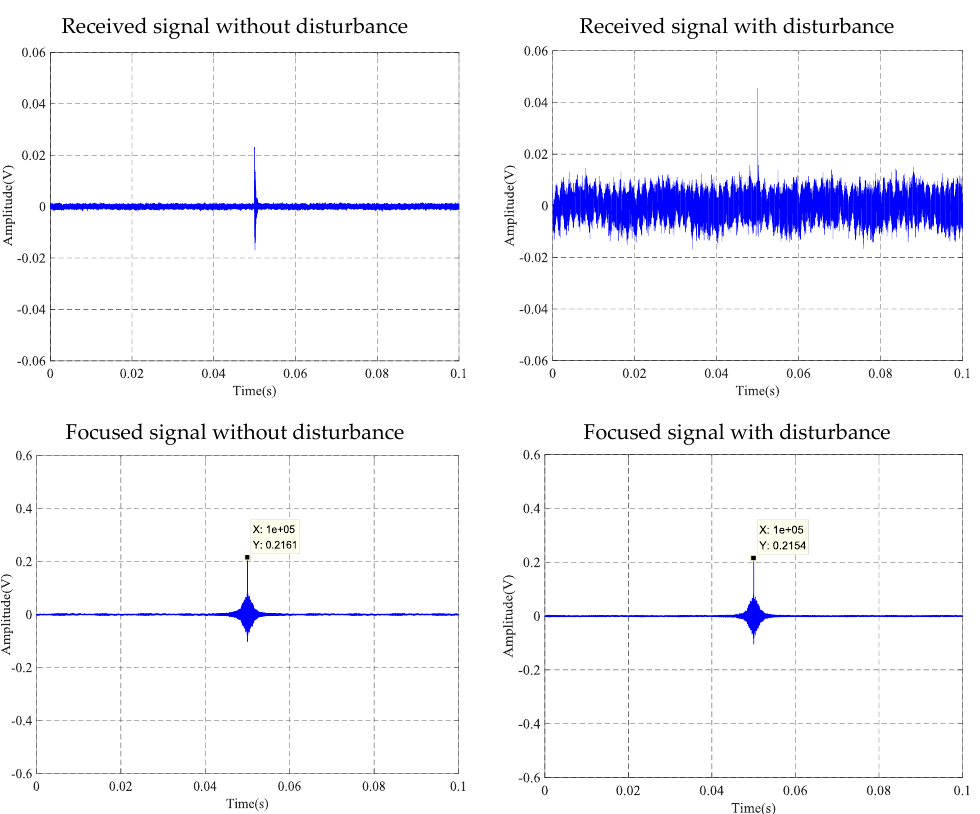
Figure 17. Anti-disturbance ability test at 0.2 MPa tension level of steel strand and barrel.